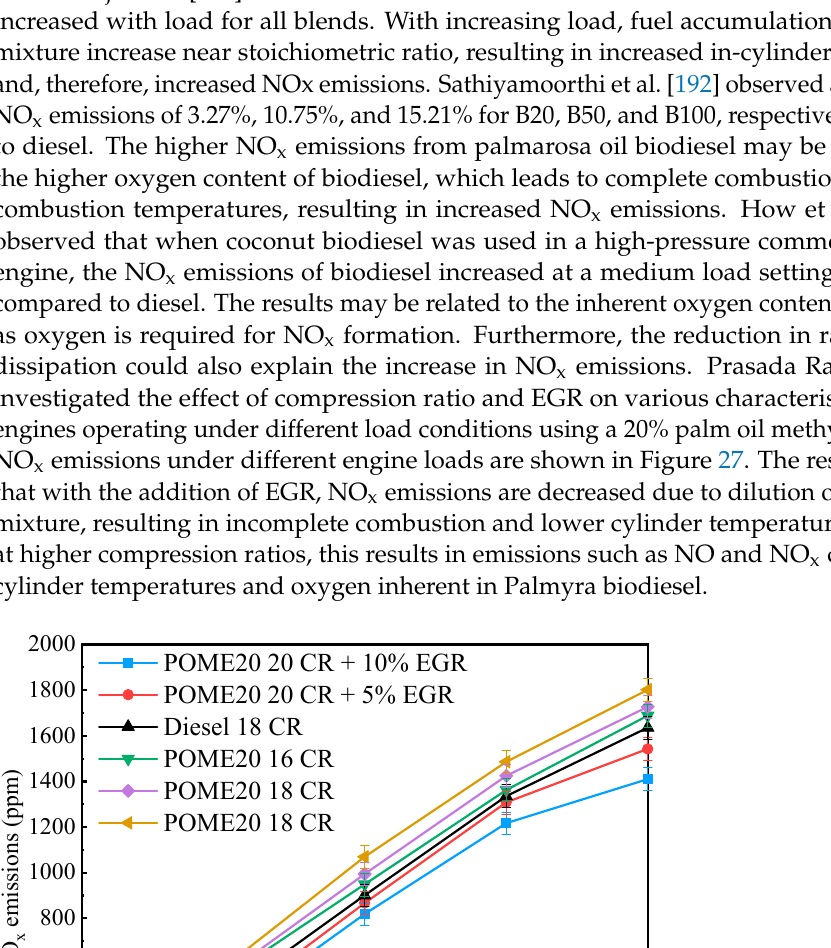
Table 8. Comparison of NO x emissions at full load and different CRs [242]. CR